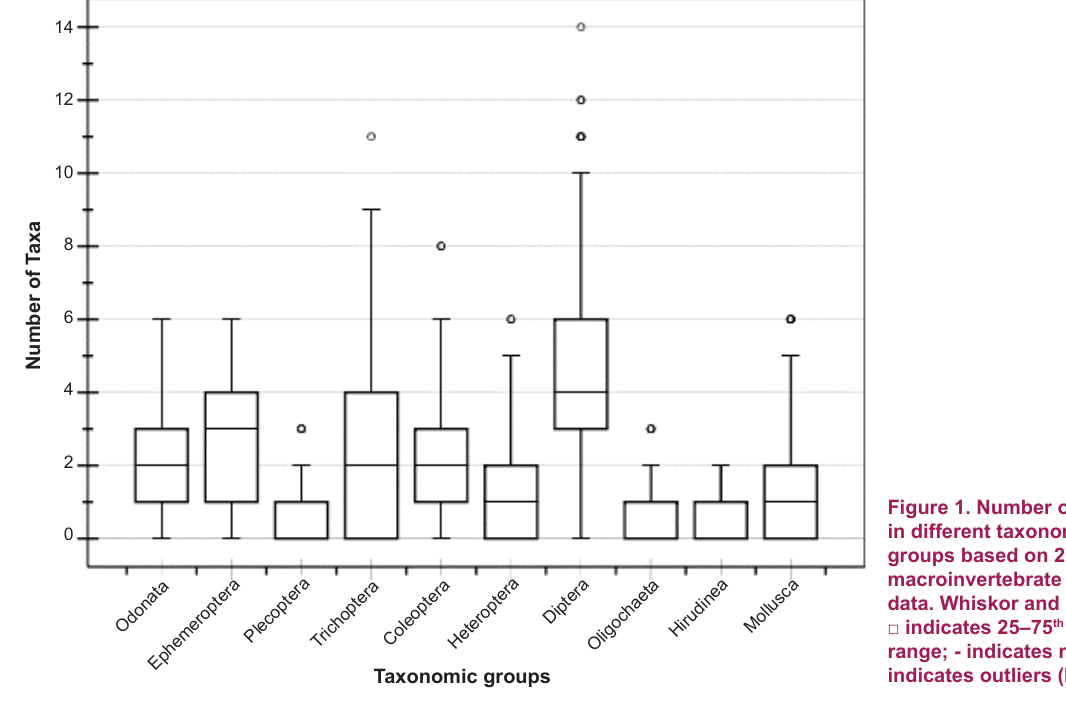
Figure 1. Number of taxa in different taxonomic groups based on 250 macroinvertebrate samples data. Whiskor and Box plots: □ indicates 25–75 th percentile range; - indicates median; o indicates outliers (both